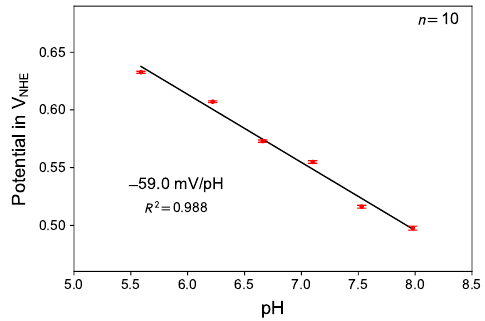
Figure 6. Influence of pH value: Measurement in air-saturated electrolyte with different pH. Potential is plotted with respect to normal hydrogen electrode